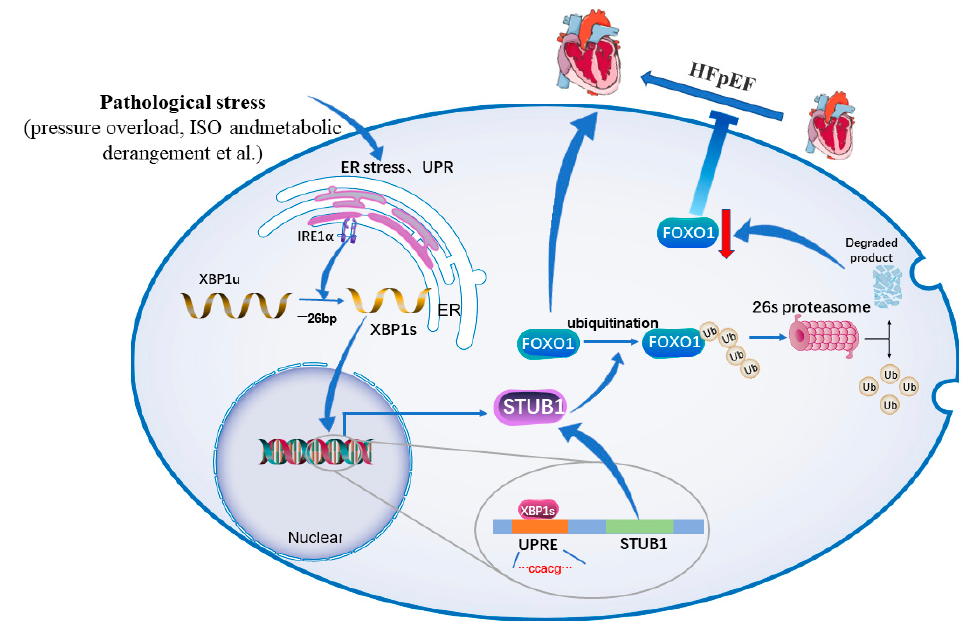
Figure 5. Schematic representation of the critical molecular mechanism of XBP1s in heart failure. Endoplasmic reticulum stress occurs in normal cardiomyocytes, XBP1s promotes the transcription of E3 ubiquitin ligase STUB1 by binding to the UPRE domain and promotes the ubiquitinated proteasomal degradation of FOXO1, thereby inhibiting the progression of heart failure. Under long-term pathological stimulation, endoplasmic reticulum stress is inhibited, XBP1 splicing is reduced, and FOXO1 is increased, promoting the progression of heart failure. FOXO1: Forkhead box protein O1, STUB1: STIP1 homology and U − Box − containing protein 1, ER: endoplasmic reticulum, UPR: unfolded protein response.